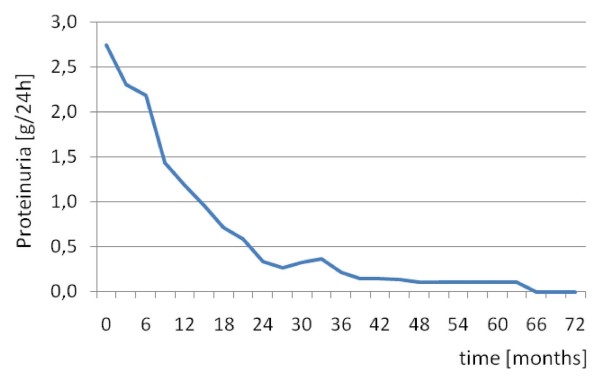
Proteinuria values during follow-up.